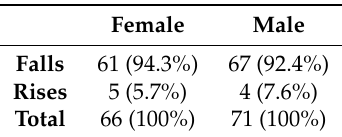
Table 5. Percentage of information-seeking yes / no interrogatives with falling and rising final contours according to speakers’